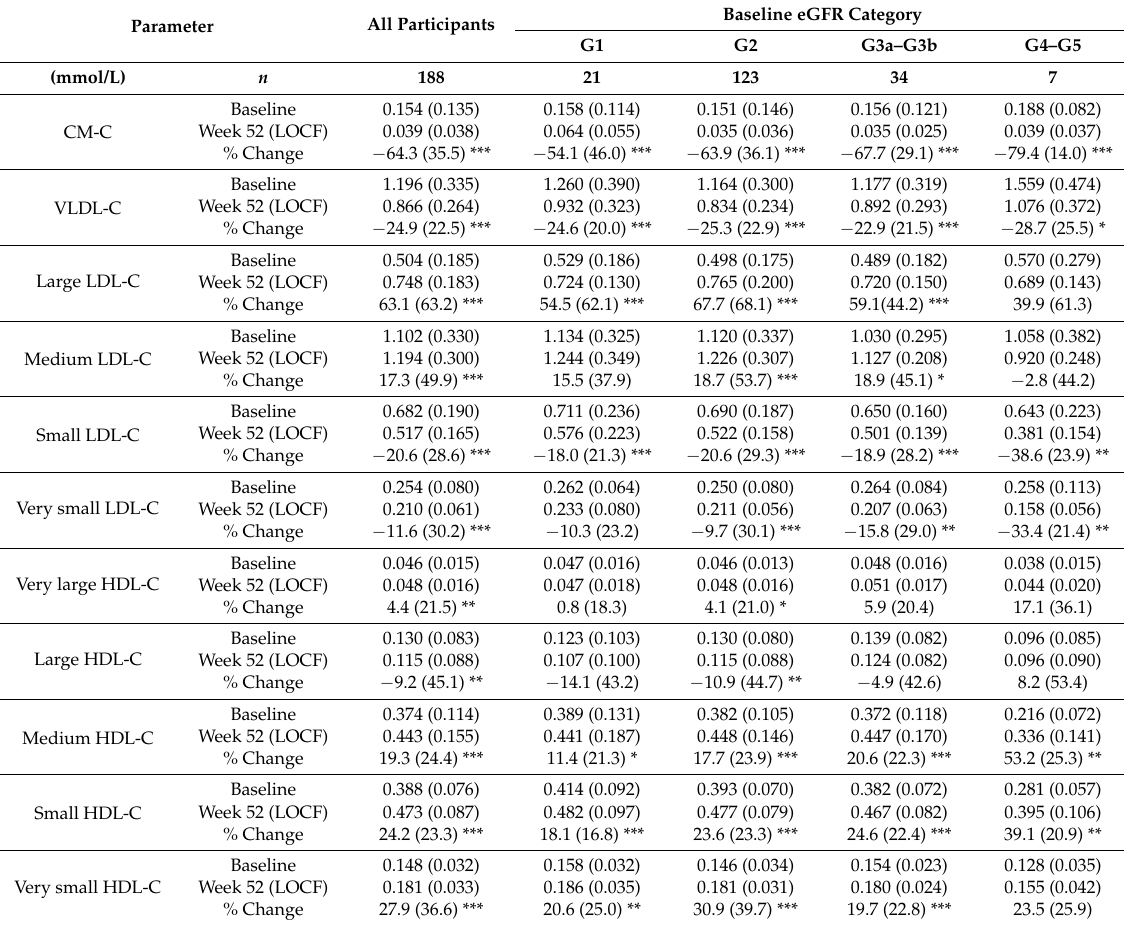
Table 3. Changes from baseline in the level of cholesterol in CM, VLDL, LDL, and HDL subclasses measured by